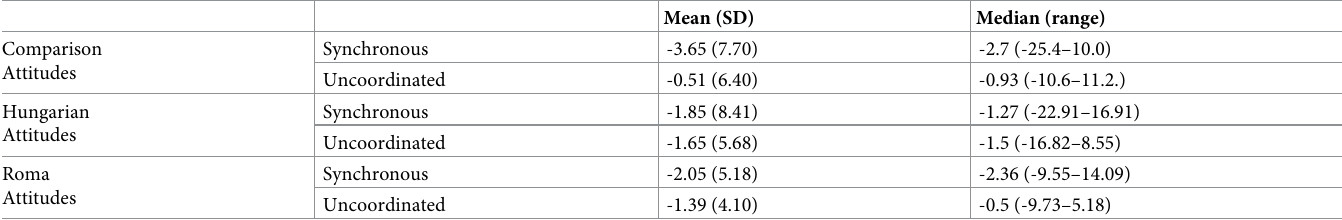
Table 8. Descriptive statistics for the all Attitude change scores for Study 2.